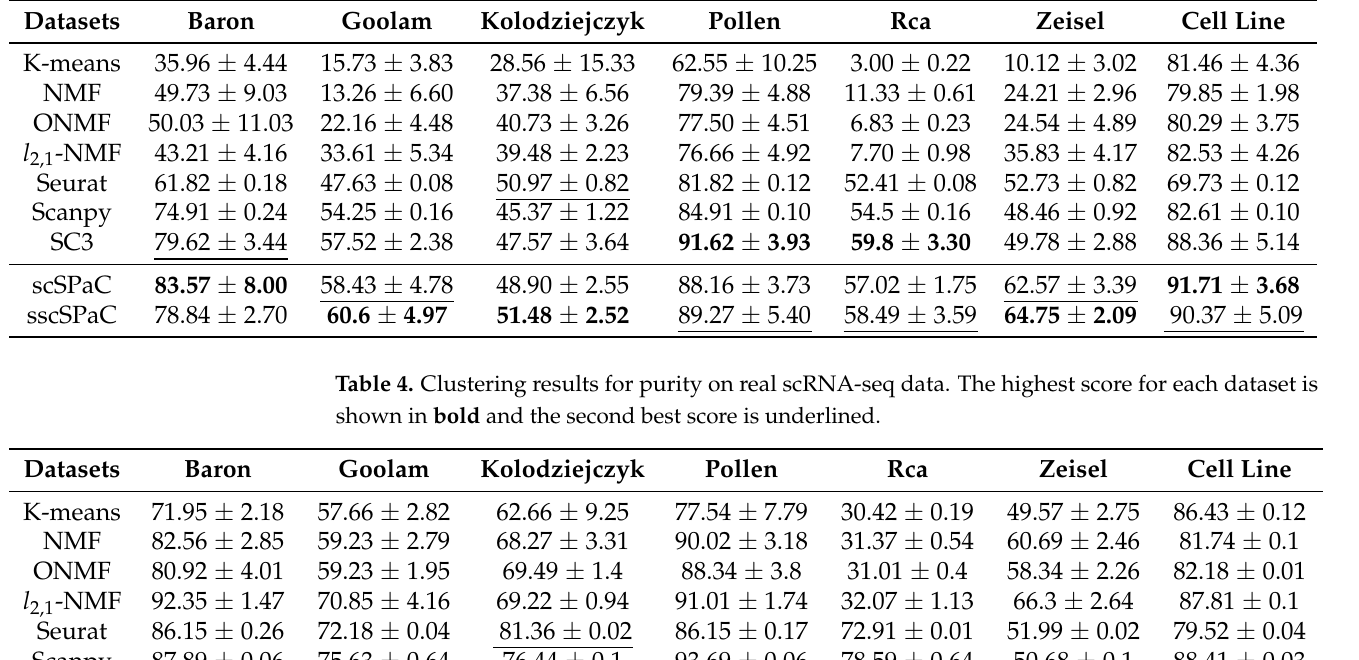
Table 3. Clustering results for ARI on real scRNA-seq data. The highest score for each dataset is shown in bold and the second best score is underlined. scSPaC and sscSPaC are based on the F-norm and l 2,1 -norm NMF with a self-paced learning single cell selection strategy.